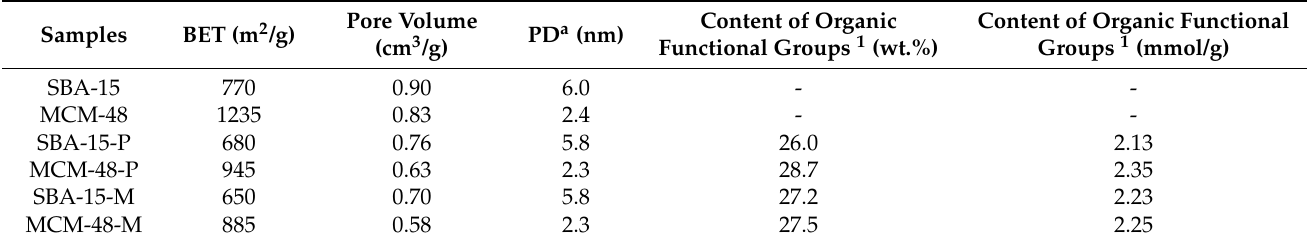
Figure 2. N 2 adsorption/desorption isotherms of the initial and the modified SBA-15 ( a ) and MCM-48 ( b ) materials. The calculated textural parameters for all samples are presented in Table 1. Table 1. Textural data and the content of the formed functional groups in the prepared materials.